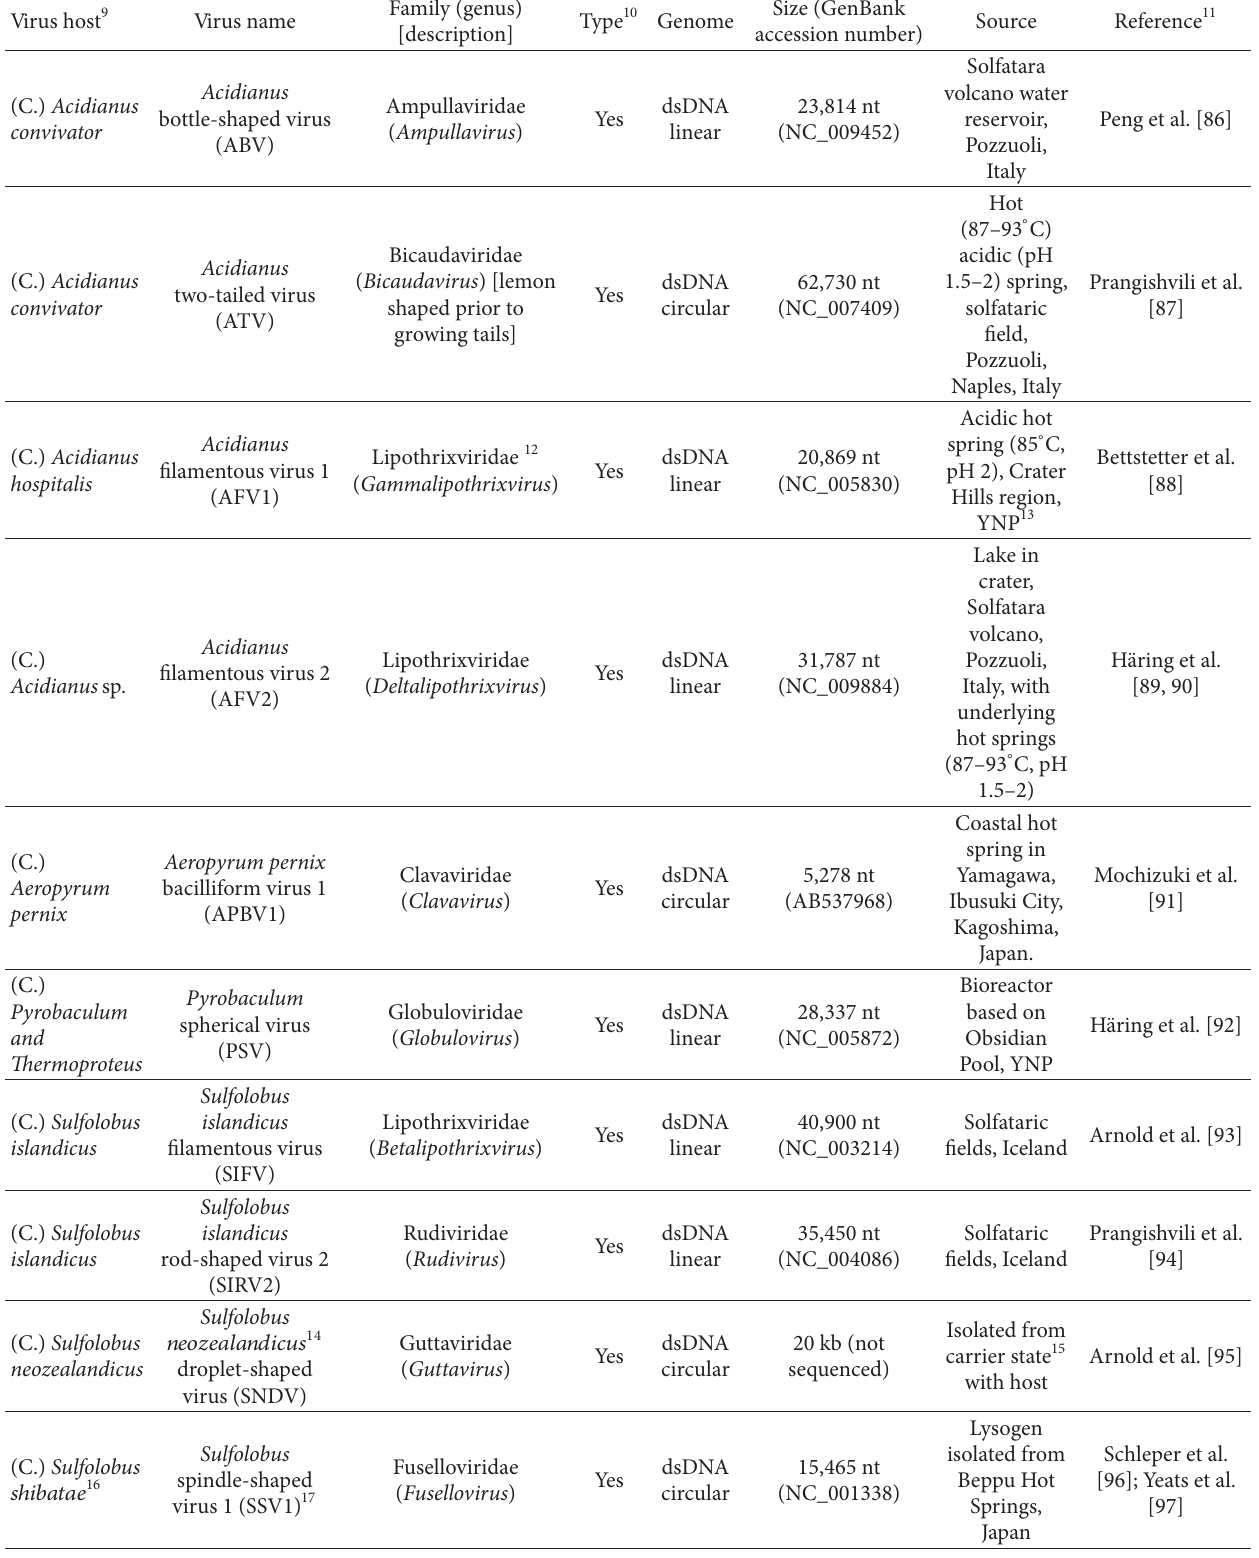
T 2: Representative sequenced archaeal viruses emphasizing diversity of virion structure. Virus